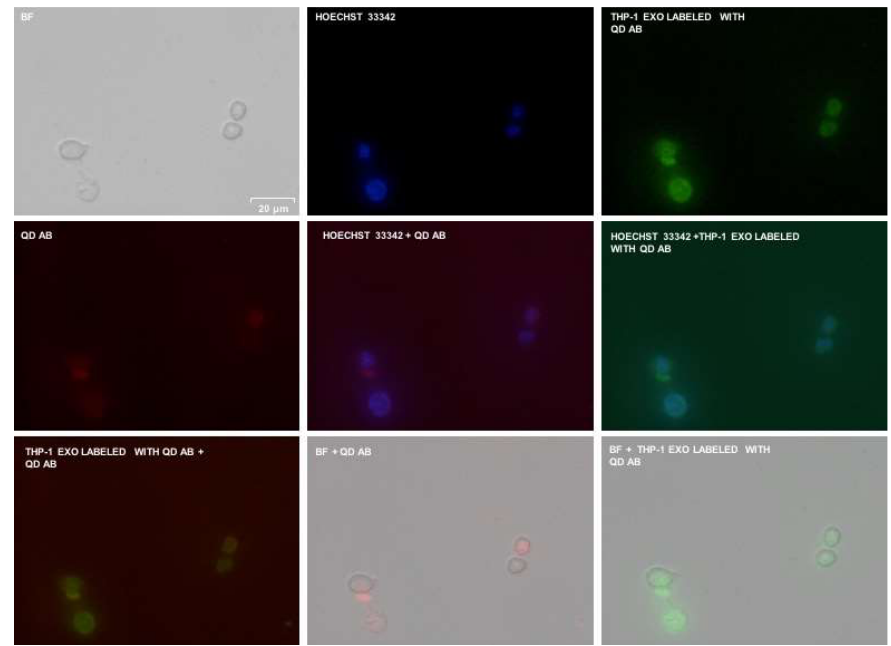
Figure 6. Fluorescence microscopy performed on RAW 264.7 with InP/ZnS–Anti-CD63 labeled exosomes (THP-1 derived) and InP/ZnS–Anti-CD63.